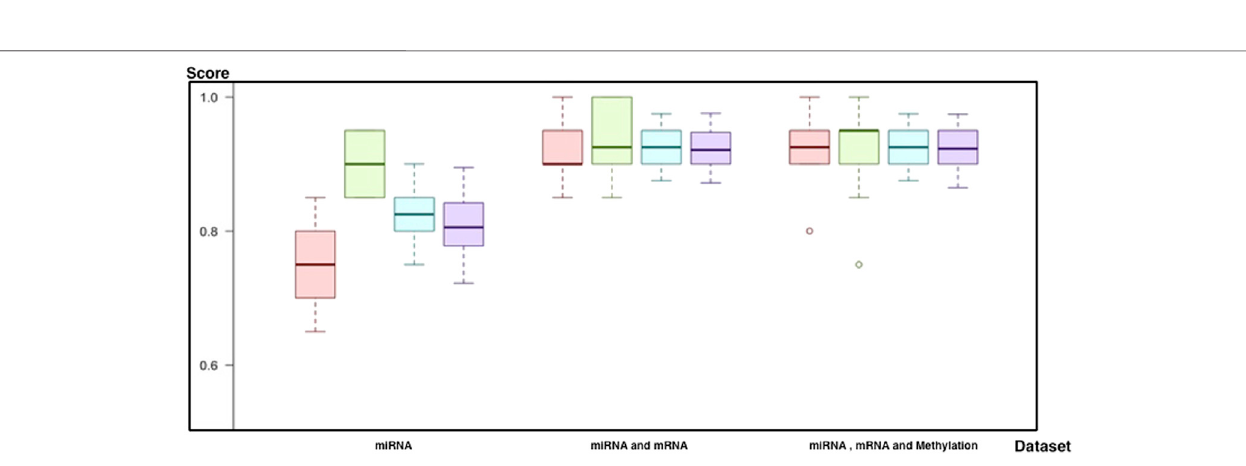
FIGURE 9 | Comparison of best models for each biomarker set (red, sensitivity; green, predictivity; blue, accuracy; purple, F-score): 1) the performance of the predictive model by using miRNA, 2) the performance of the predictive model by using miRNA and mRNA markers, and 3) the performance of the predictive model by using miRNA, mRNA, and methylation